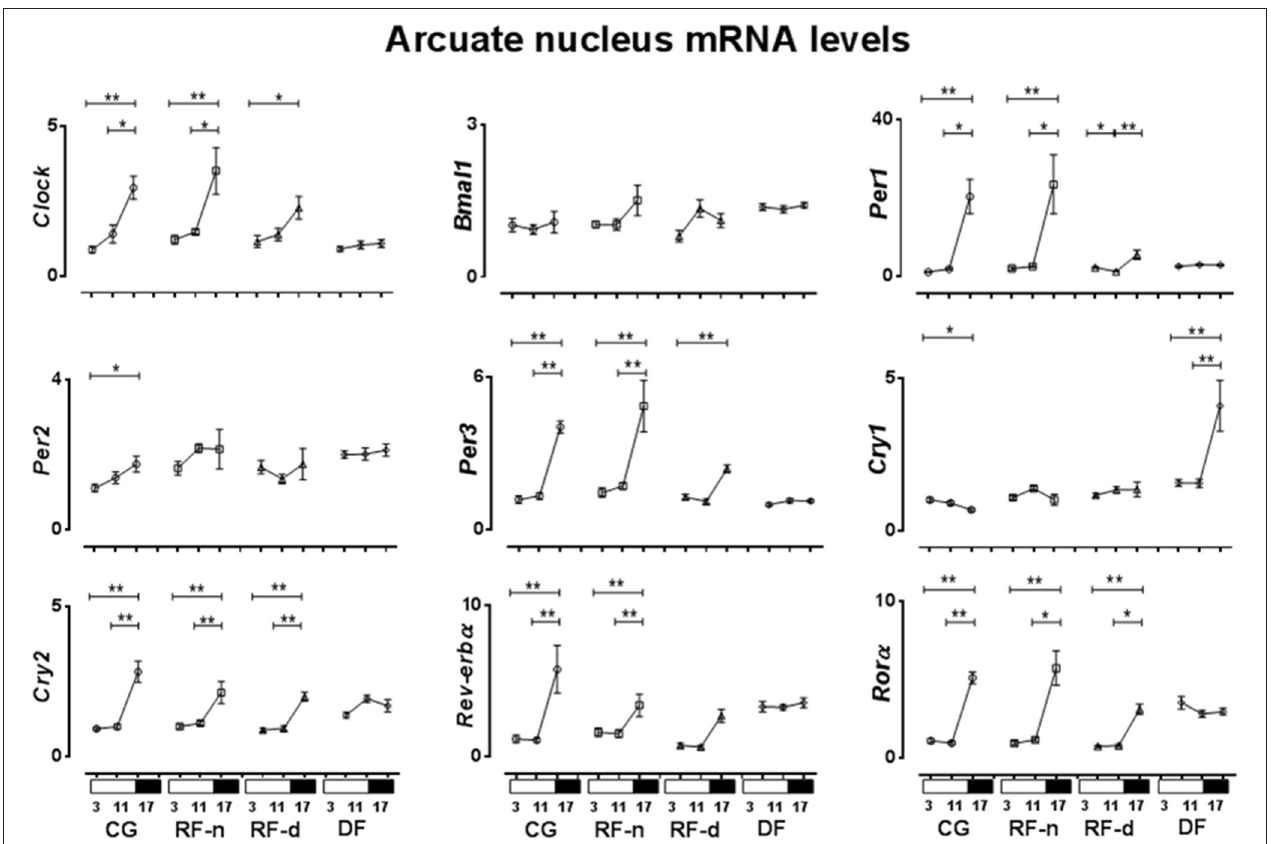
FIGURE 5 | Relative expression of clock genes in Arcuate nucleus (ARC) in the control group, with food ad libitum ; restricted night-fed group (RF-night), with access to food restricted to ZT12–ZT14 (1800–2000h); restricted day-fed group (RF-day), with access to food restricted to ZT3–ZT5 (0900–1100h); and day-fed group (DF), with access to food restricted to ZT0–ZT12 (0600–1800h) at ZT3, ZT11, and ZT17, corresponding to 0900, 1700, and 2300 h; respectively. N = 6–10 rats per time point per group. ZT, Zeitgeber Time. Significant difference among ZTs within the same feeding condition: * P < 0.05, ** P <